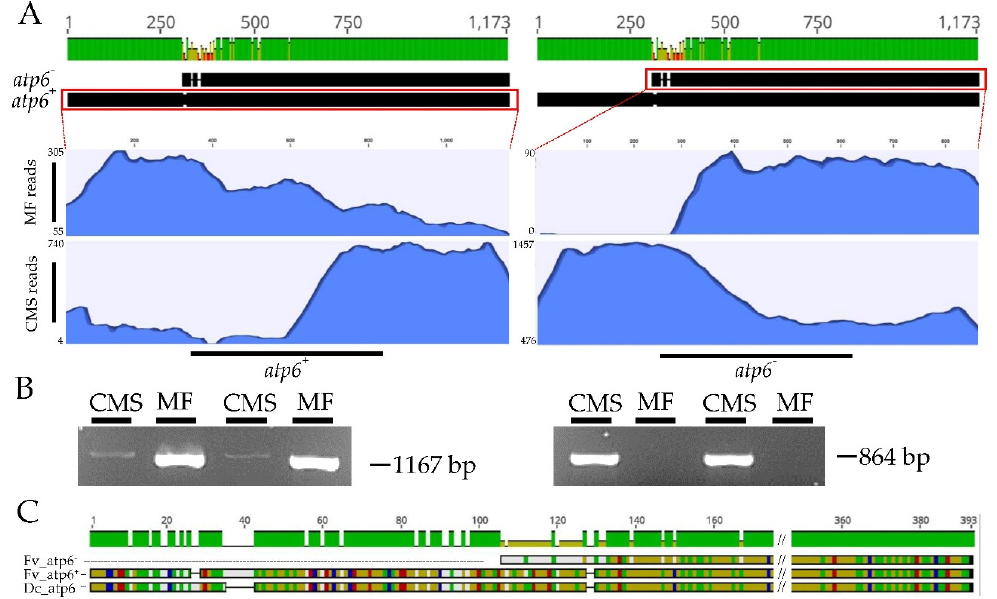
Figure 3. ( A ) Nucleotide alignment between the two atp6 copies retrieved within the mitochondrial genomes of Foeniculum vulgare. atp6 + indicates the wild type gene (1,167 bp) found in the male fertile (MF) mtDNA while atp6 − is an atp6 -like sequence lacking the first 300 bp (864 bp) retrieved in the cytoplasmic male sterile (CMS) mtDNA. Raw sequencing reads from MF and CMS accessions were mapped to atp6 + and atp6 − . ( B ) PCR profiles generated in two CMS commercial lines and their MF maintainers with specific primers for atp6 + (left) and atp6 − (right). ( C ) Protein alignment of atp6 + , atp6 − , and the atp6 protein from Daucus carota